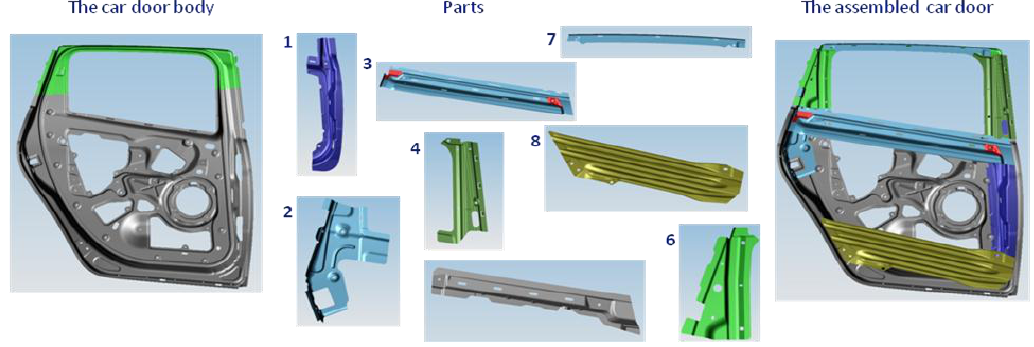
Figure 13. Assembly process of a car